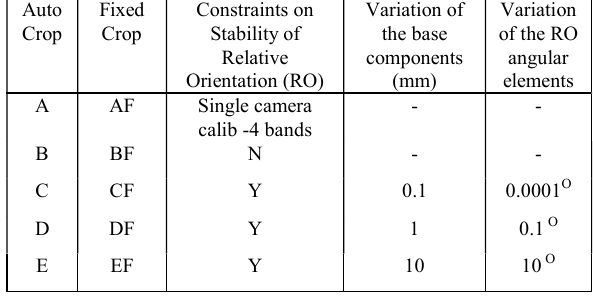
Table 3. Configurations used in the experiments.